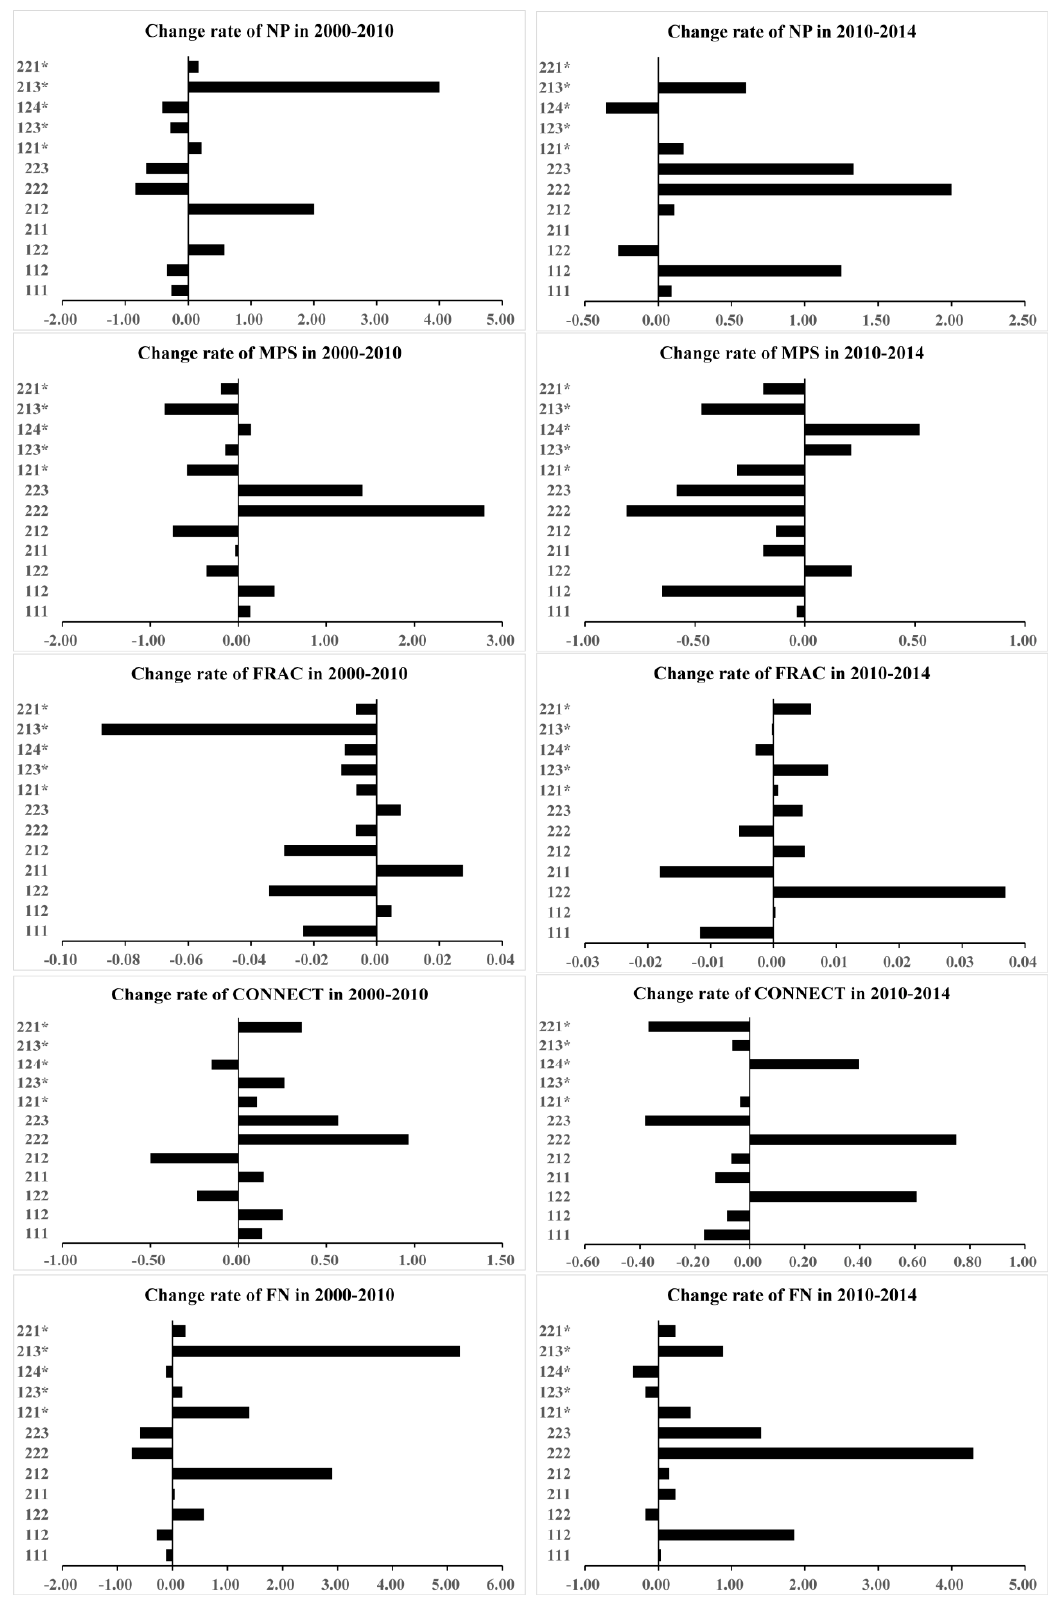
Figure 7. Change rate of agricultural land landscape indices for each community in 2000–2010 and 2010–2014. * indicates communities that implemented RFFP. Refer to Table 3 for the abbreviations for landscape metrics.